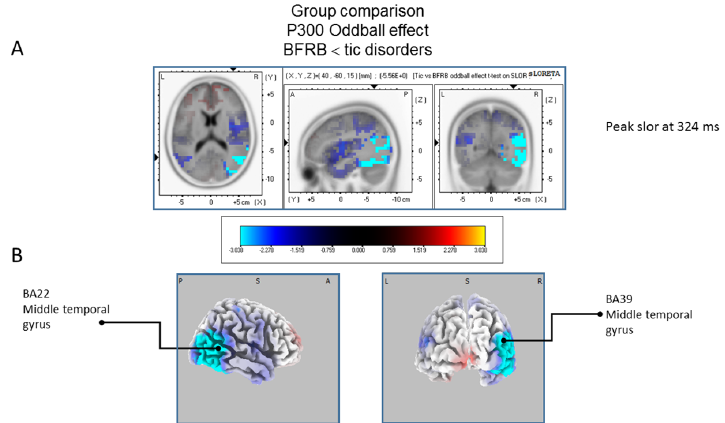
Figure 6. Comparison of the oddball effect between Tic and BFRB patients based on the standardized low-resolution brain electrotomography (sLORETA) current source density localization ofthe group effect (contrast: “BFRB” < “tic”) in the peak activation of the P300 component within a 300–550 ms time window. Images have been obtained after statistical non-parametric mapping (SnPM) and co-registration to the stereotaxic Talairach space based on the Co-Planar Stereotaxic Atlas of the Human Brain [83] and the probabilistic MNI-152 template [81]. Activated voxels are indicated by blue colors (after correction for multiple comparisons ( p < 0.05)). ( A ) The peak of highest cortical activity of group difference has been found in parts of the middle temporal gyrus (BA22) and the middle temporal gyrus (BA39). ( B ) A shifted transverse and coronal view of the right hemisphere and the occipital region, showing cortical activations on the three-dimensionally rendered Colin27 template [89]. A, anterior; P, posterior; L, Left; R, Right. MNI, Montreal Neurological Institute; X, Y, Z, corresponding MNI coordinates; BA, Brodmann area.